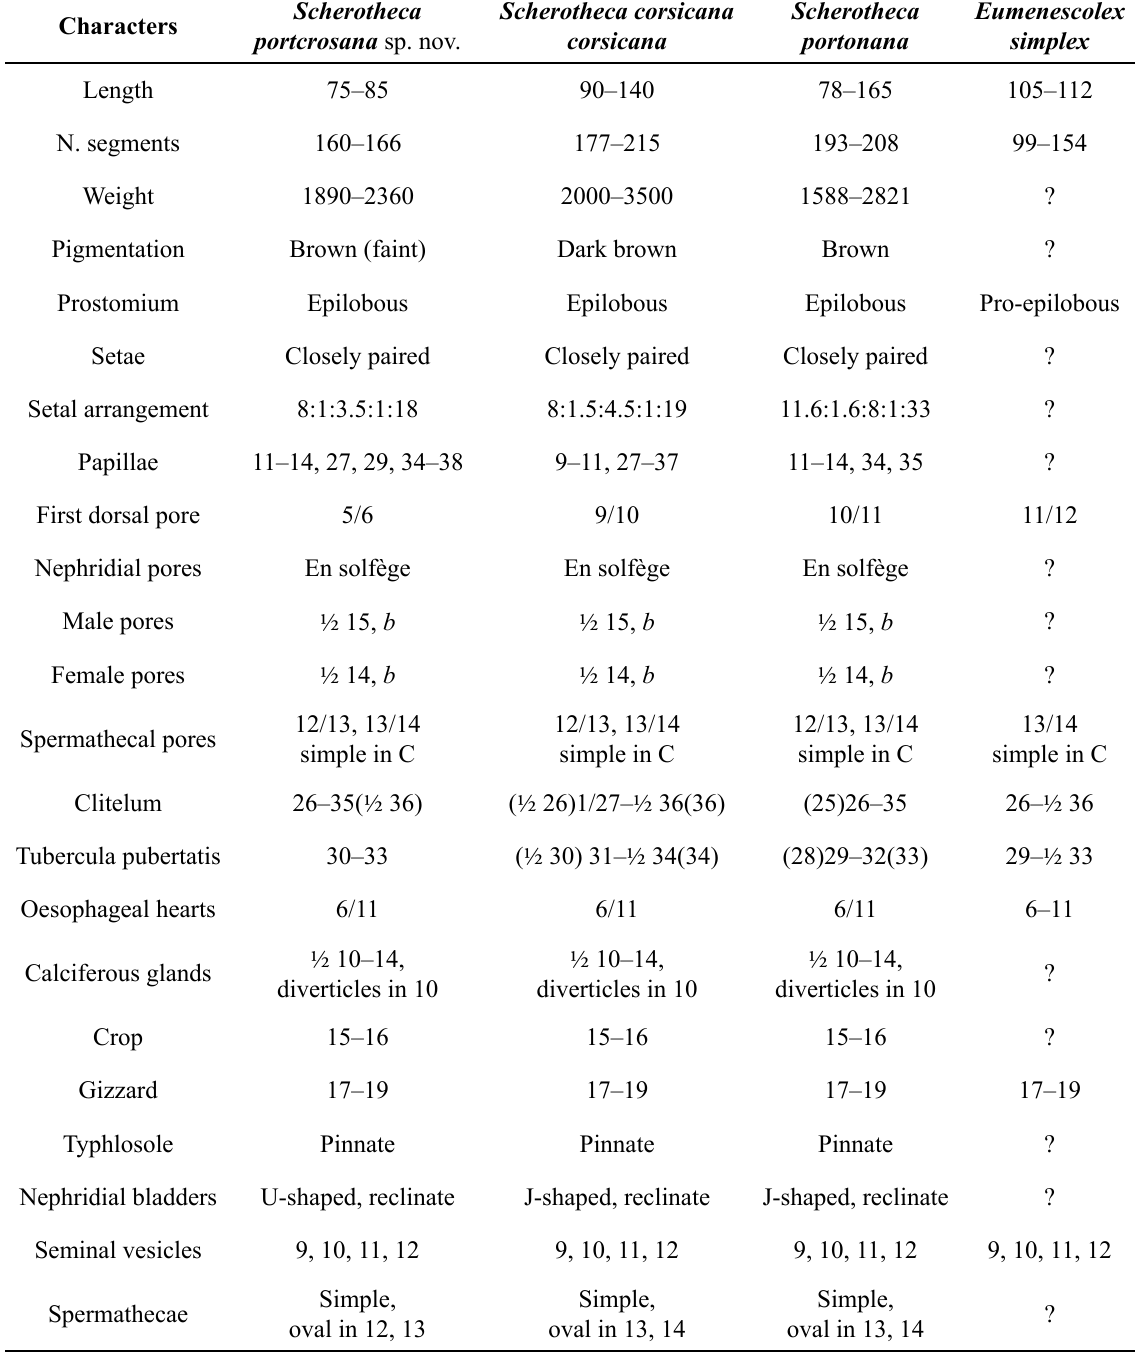
Table 4. Morphological characters of Scherotheca portcrosana Marchán & Decäens sp. nov. and morphologically similar relatives of genera Scherotheca Bouché, 1972 and Eumenescolex Qiu & Bouché, 1998 . Length expressed in mm, weight expressed in